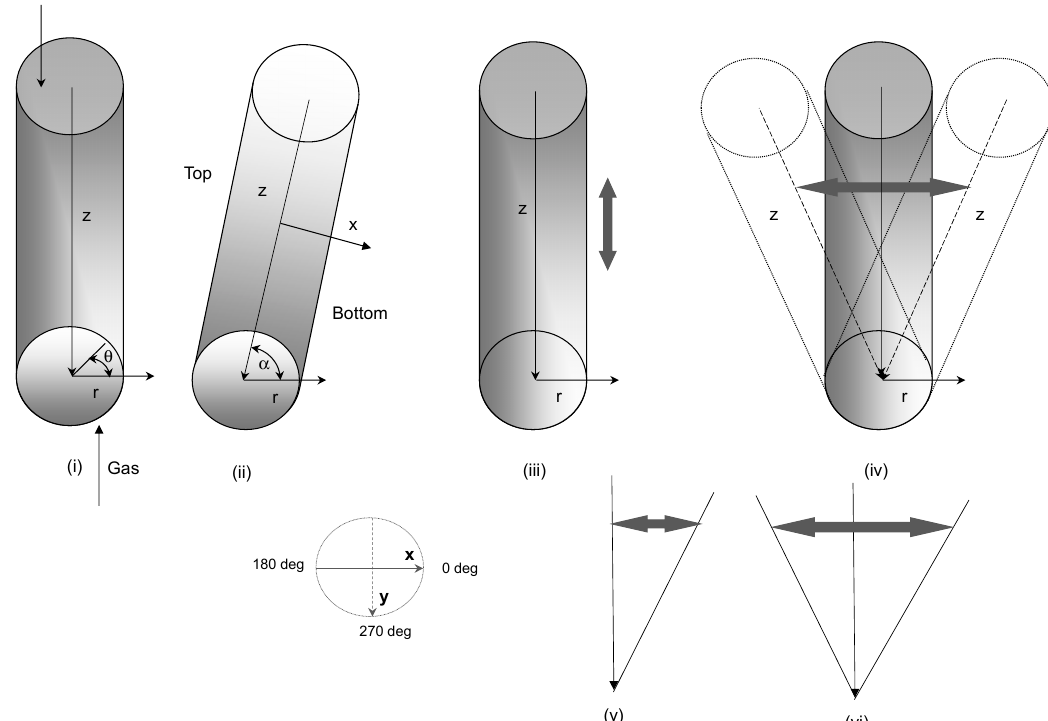
Figure 1. Configuration of seawater scrubber: ( i ) Vertical scrubber, ( ii ) inclined scrubber, ( iii ) scrubber under heaving motion, ( iv ) oscillating scrubber between two symmetrical inclined positions, ( v ) oscillating scrubber between the vertical and an inclined position, ( vi ) oscillating scrubber between two asymmetrical inclined positions.